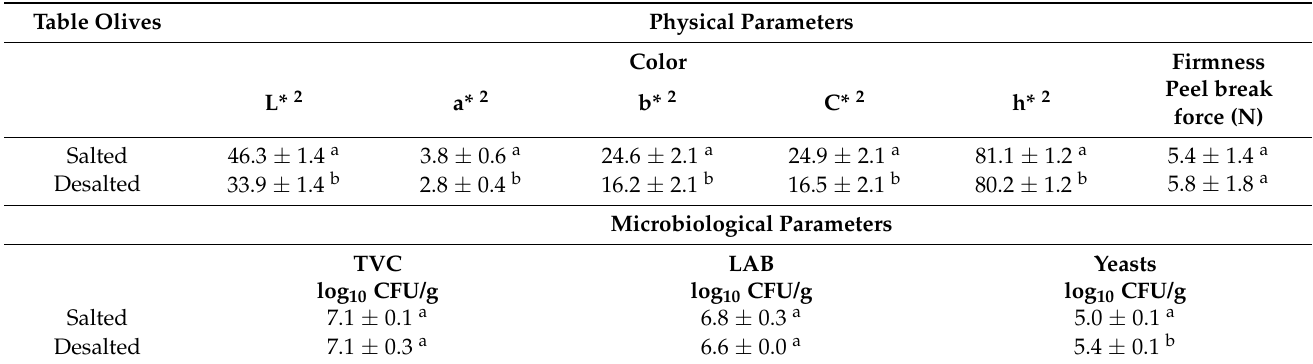
Table 2. Physical and microbiological parameters 1 of starting materials (table olives). Table Olives Physical Parameters Color Firmness L*